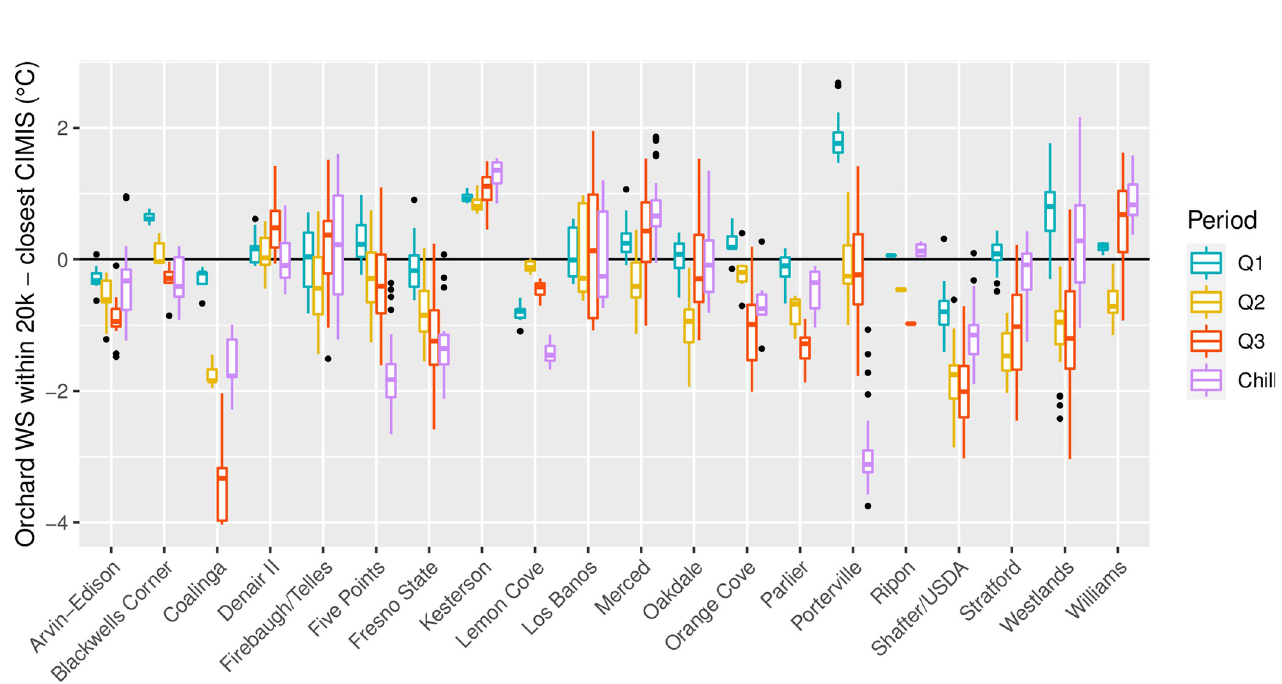
Fig 7. Discrepancies between in-orchard stations within 20 kilometers from a CIMIS station and that CIMIS station mean temperature during the first (Q1), second (Q2), and third (Q3) quarter of 2020, and the following chill period (chill; September 1st 2020 to February 28th 2021).